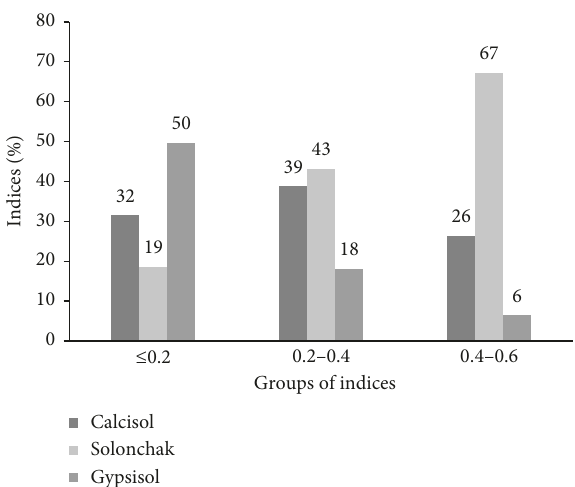
Figure 8: Histogram of frequencies of groups of indices.